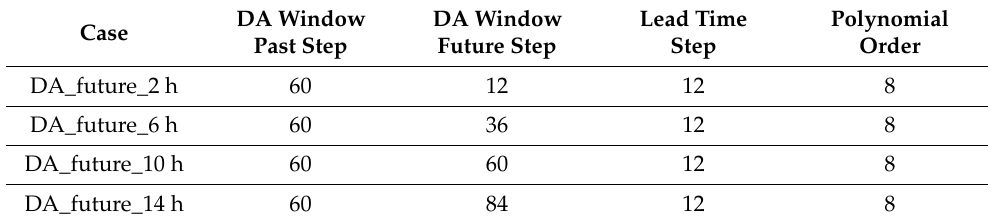
Table 4. The conditions for DA experiment 2-1: varying the future DA window. Table 3. The conditions for DA experiment 2-1: varying the past DA window.